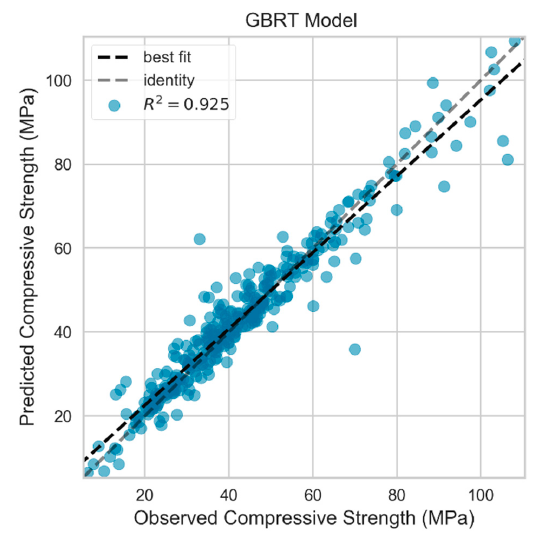
Figure 10. Actual vs. predicted values for testing set in GBRT model.